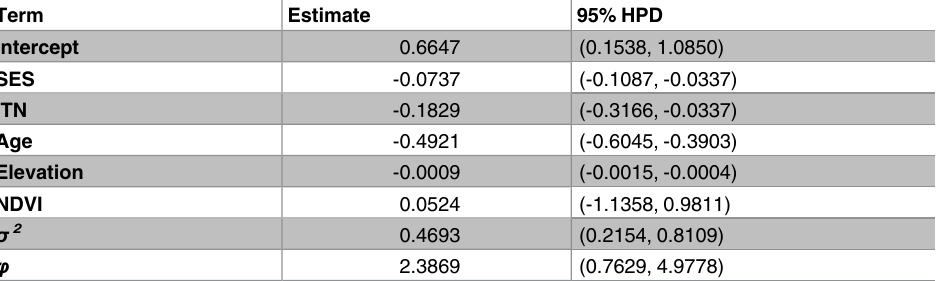
HPD = Highest Posterior Density, ITN = Insecticide-Treated Net (availability of at least one in household), NDVI = Normalised Difference Vegetation Index, SES = Social Economic